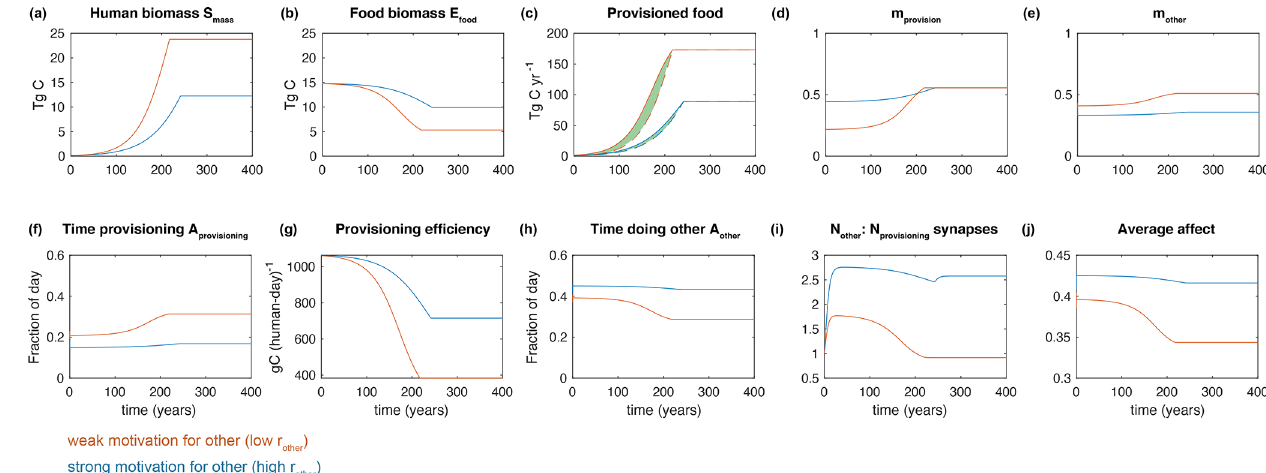
Figure 6. Time series of two model experiments with different values of r other